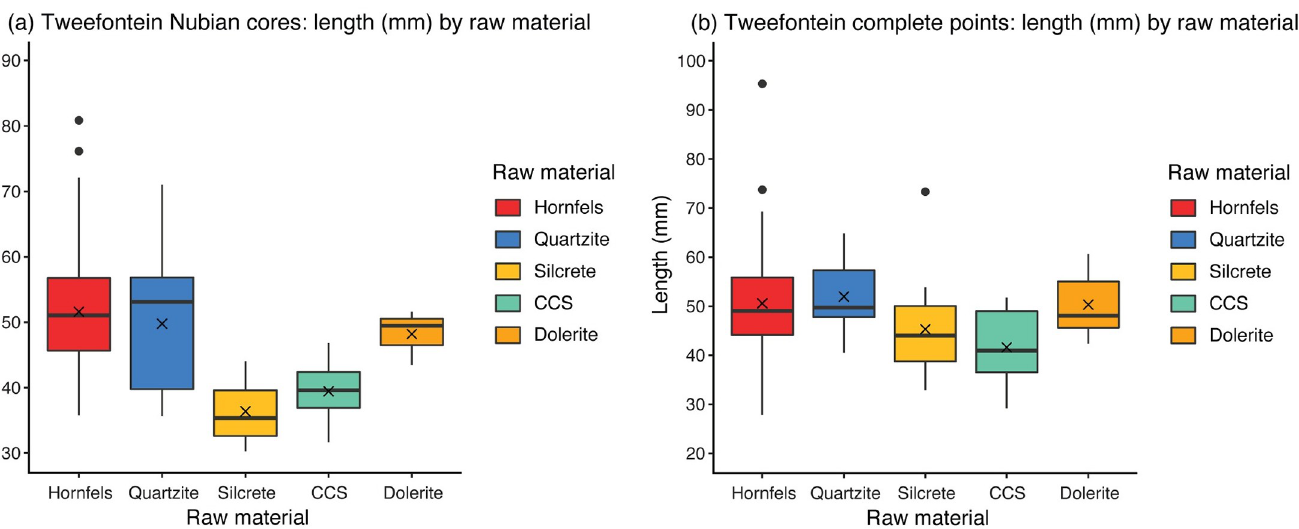
PLOS ONE | https://doi.org/10.1371/journal.pone.0241068 October 22,